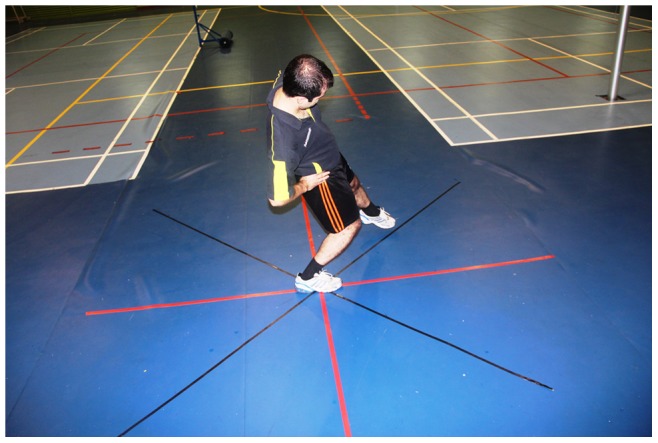
Anterior medial direction of the SEBT with a right stance leg.